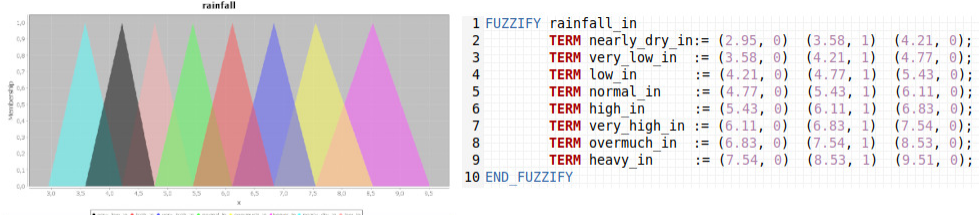
Figure 11. Rainfall membership classes.